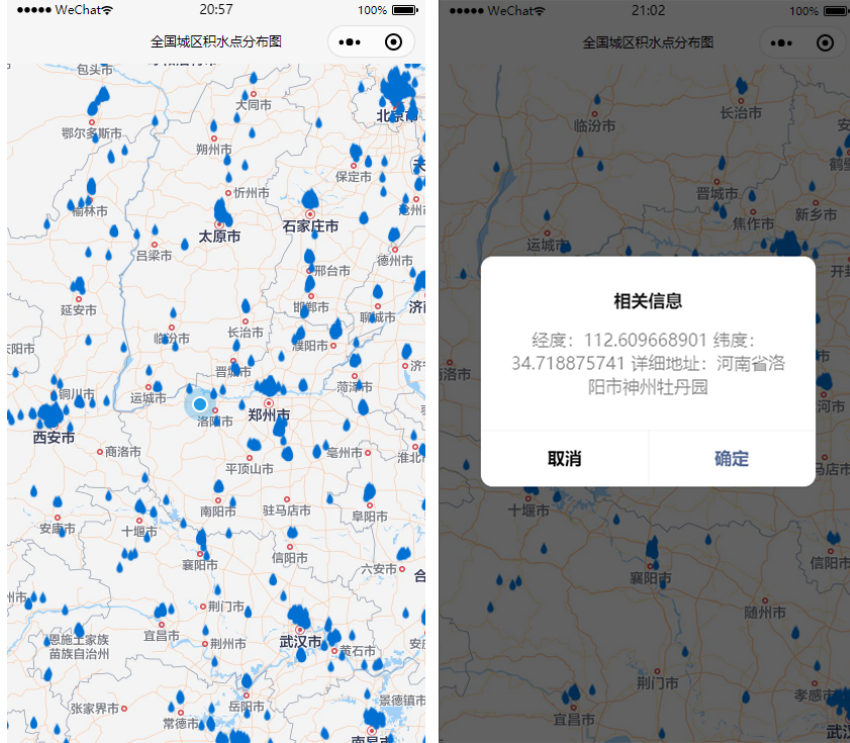
Figure 9. Screenshots of the monitoring system based on the WeChat applet. (a) Nationwide map of urban waterlogging (© Tencent Maps) and (b) detailed information of one waterlogging